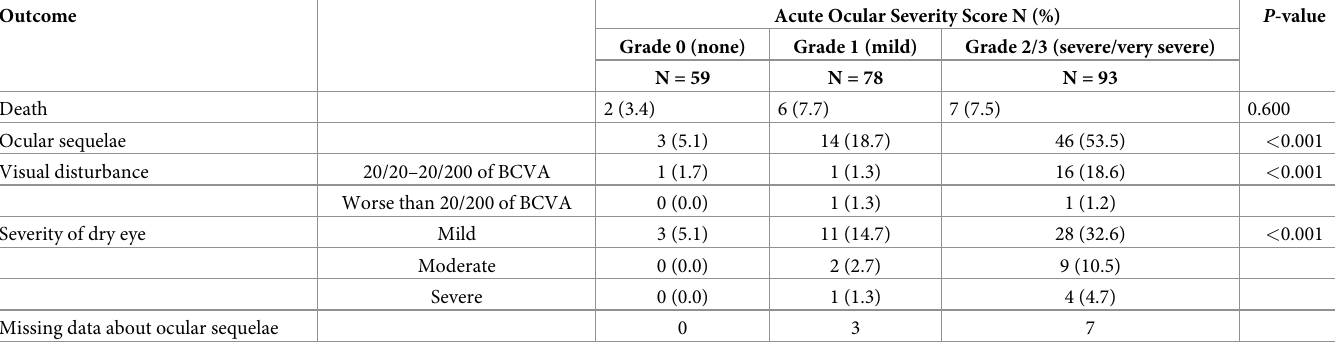
Table 3. Correlation between outcomes or ocular sequelae and acute ocular severity score at worst-condition follow-up visit.